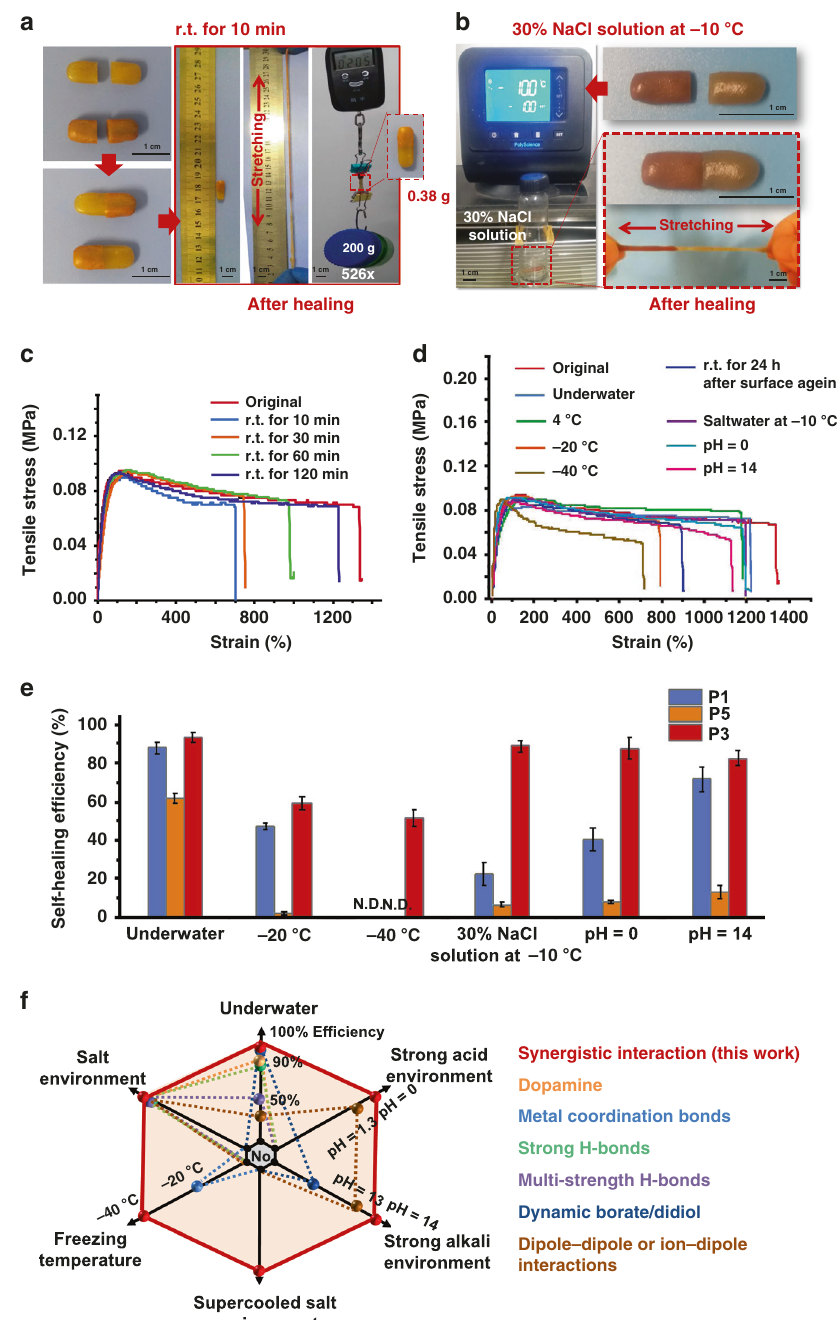
Fig. 3 Universally self-healing capability of PDMS – SS – IP – BNB elastomer. a Photographs of P3 fi lm (left) before and (right) after self-healing and enabling high stretchability and holding a weight that is 526 times greater than that of the fi lm. b Self-healing of P3 fi lm in a 30% NaCl solution at − 10 °C. P3 fi lm is bisected and put together in a 30% NaCl solution at − 10 °C. After 24 h self-healing, the fi lm is removed and can be stretchable. c Stress – strain curves of the P3 fi lm healed for different time periods at room temperature (r.t.). Stretching ability increases when the fi lm is allowed to heal for a longer time. d The stress – strain curves of P3 fi lm healed under universal conditions. Sample width, 14 mm; thickness, 1 mm; gage length, 2 mm. Stretching speed, 10 mm min − 1 e The self-healing ef fi ciency (%) of P1 (lack of strong H-bonds), P3, and P5 (lack of S – S bonds) fi lm healed underwater for 12 h, at − 20 °C for 12 h, at − 40 °C for 24 h, 30% NaCl solution at − 10 °C for 24 h, pH = 0 and pH = 14 solution for 24 h. Sample size: 60 × 20 × 1.0 mm 3 ; Stretching speed: 10 mm min − 1 . Error bars = standard deviation ( n = 3) f A comparison between this work and previously reported self-healing materials in terms of self-healing ability in universal harsh conditions (refs. 4,5,7,8,12,19,35,40,44 – 54 ). Source data are provided as a Source Data fi